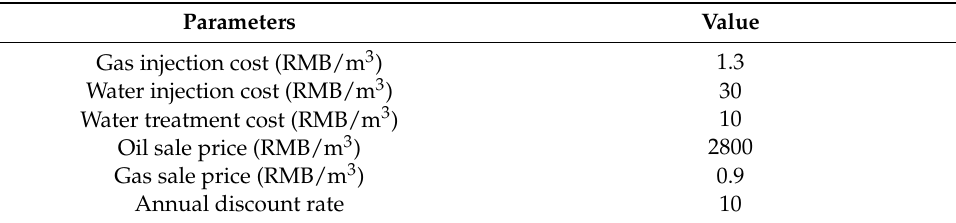
Table 2. Economic parameter